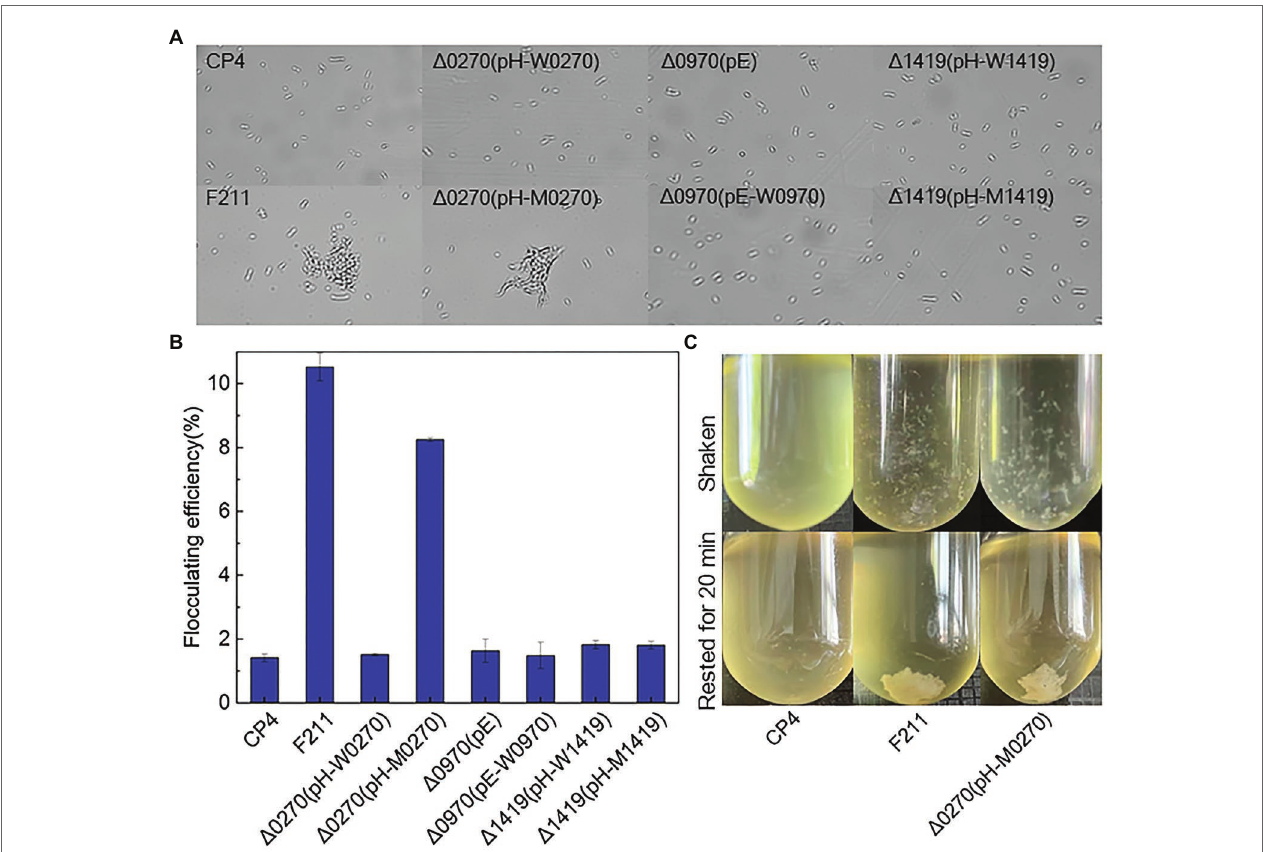
FIGURE 2 | Forces in Zymomonas mobilis flocculation. (A) Flocculent microscopic image of recombinant strains. (B) Flocculation rate. (C) Flocculation